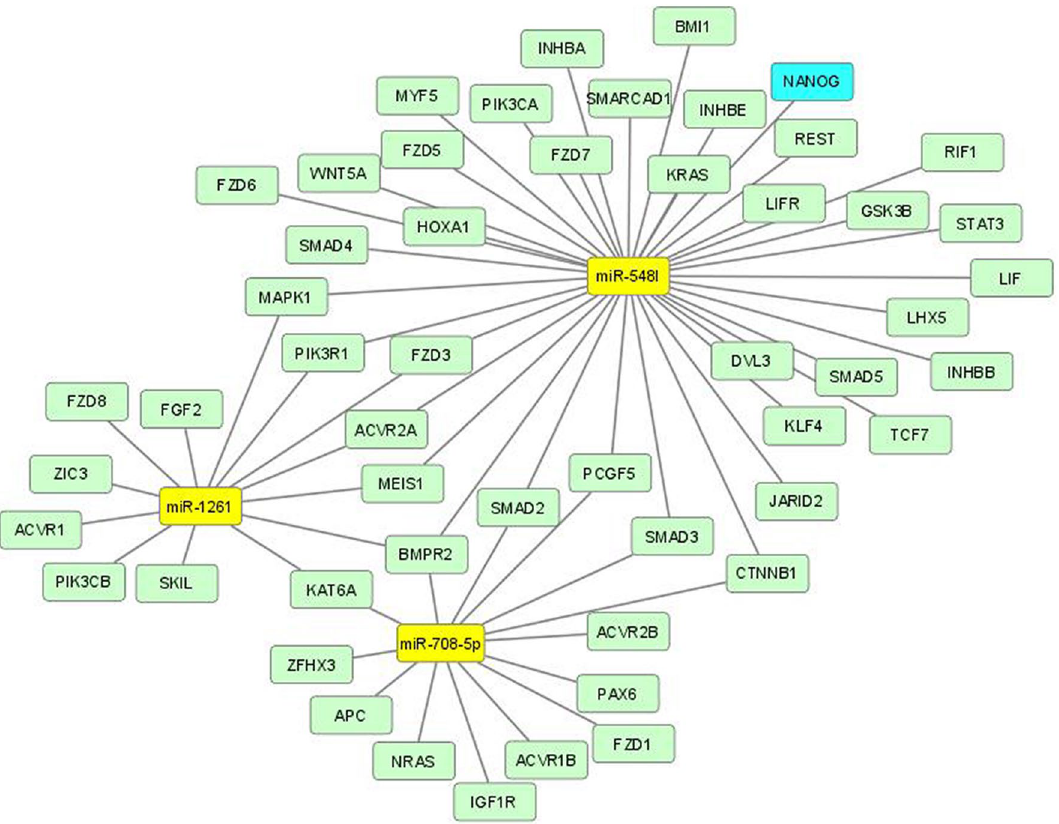
Figure 2. Network of miRNA-target mRNAs involved in signaling pathways regulating pluripotency of stem cells. The yellow box nodes represent miRNAs; green nodes describe target; blue box node represents hub